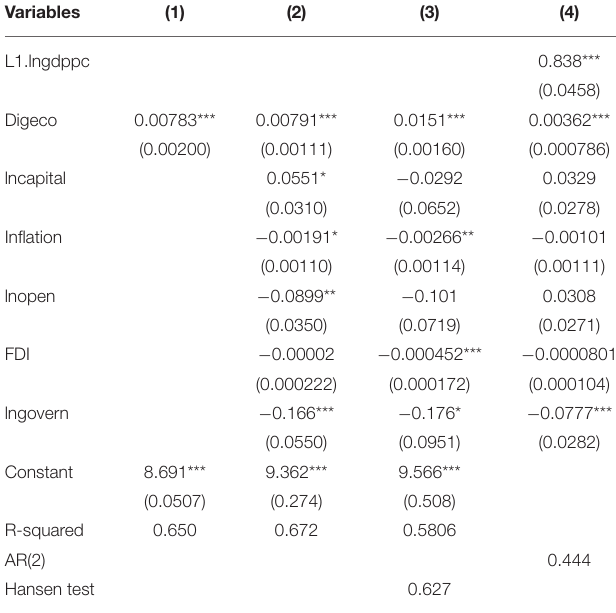
TABLE 5 | Impact of digital economy on GDP per capita of countries along the “Belt and Road.”